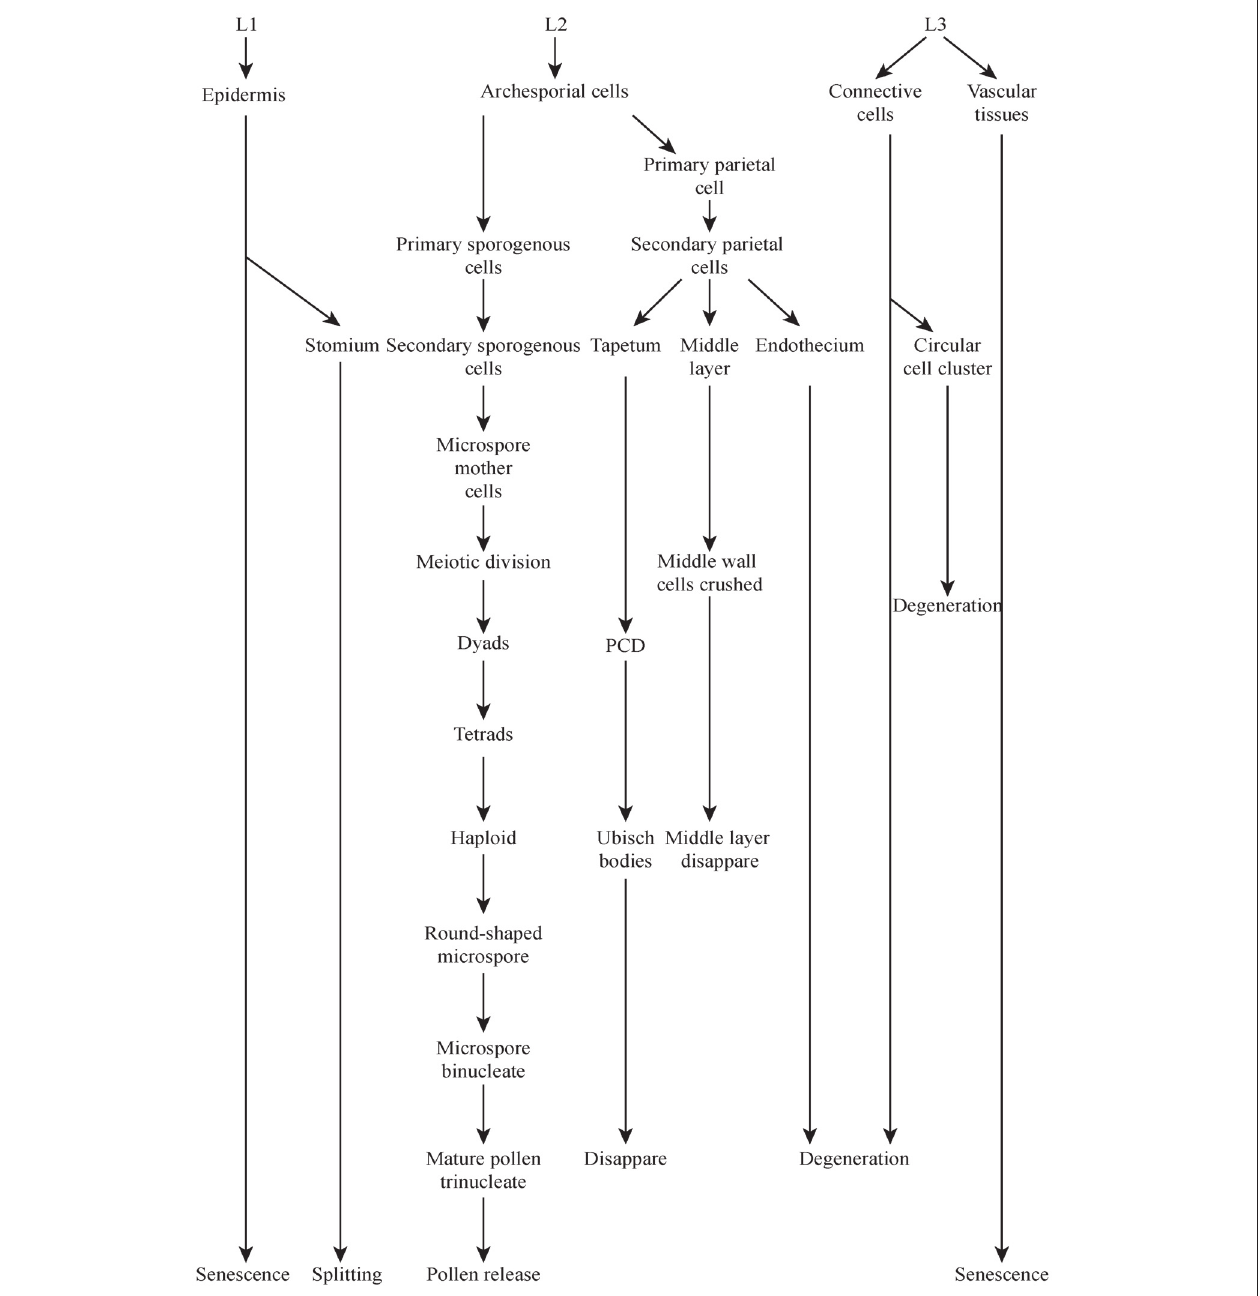
FIGURE 2 | Major events during rice microspores development and dehiscence. Development stages and events were taken from Zhang et al. (2011). Some events were marked with boxes. L1, L2, L3 means layer 1, layer 2, and layer 3, respectively.